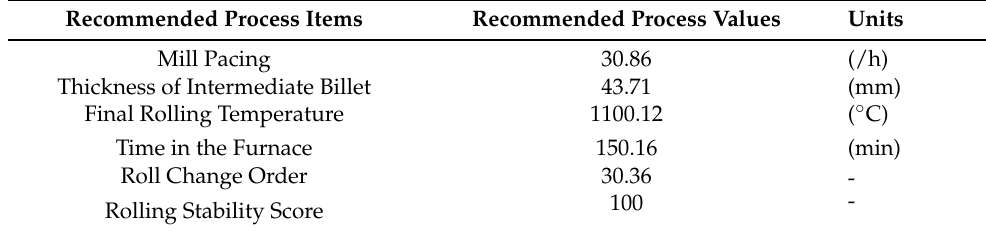
Table 7. MRTRG00201_1276_3 Recommended rolling